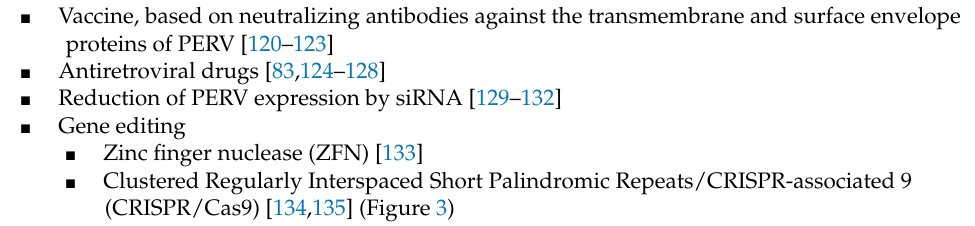
Figure 3. Inactivation of PERVs integrated in the pig genome using CRISPR/Cas and generation of piglets by somatic cell nuclear transfer (SCNT) [132]. Table 8. Strategies to prevent PERV